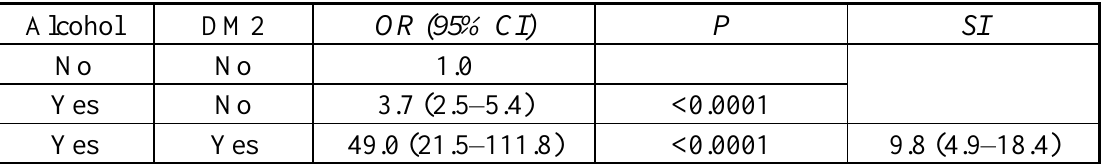
Table 7. Interactive effect of the association of type 2 Diabetes Mellitus with Alcohol abuse in HCC versus Controls